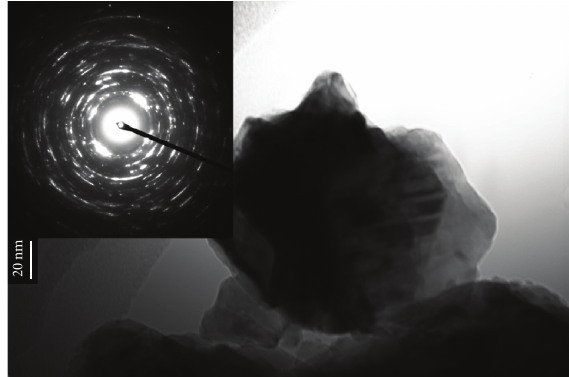
Figure 4: TEM micrograph and SAED pattern of bulk Cu 0 . 95 Fe 0 . 05 O (900 ◦ C/12h).